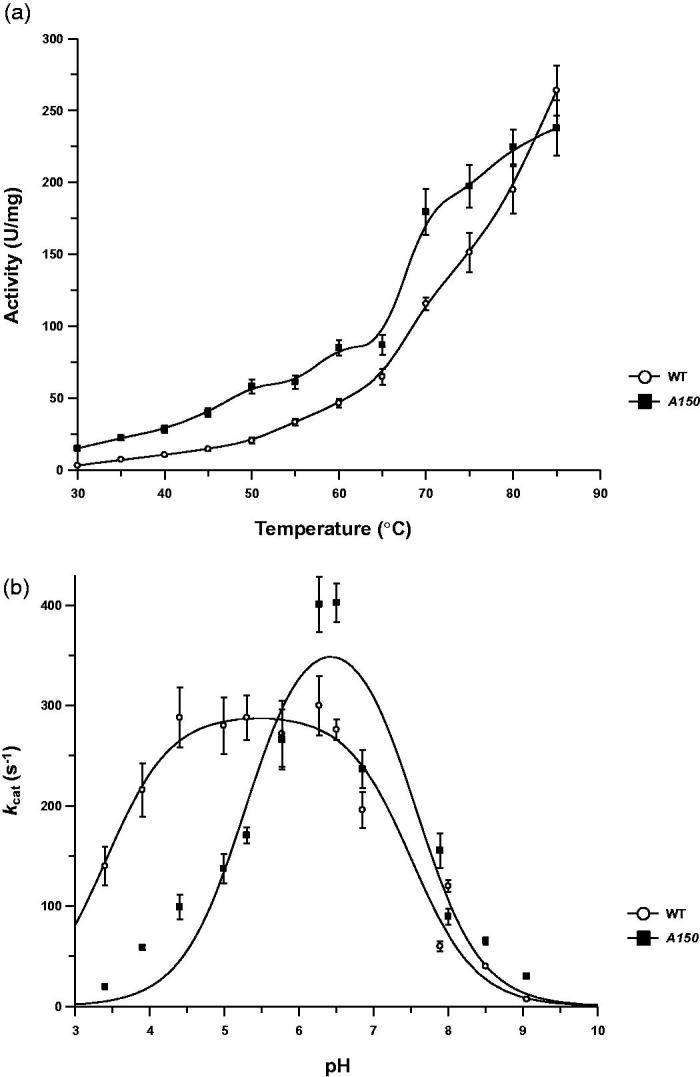
Effect of pH and temperature on wild type and mutant Ssβ-gly. Wild type Ssβ-gly (closed circles) and the A150 mutant (open squares) specific activities are shown as a function of temperature (a) and pH (b). For the wild type and mutant, the pKa1 are 3.41 ± 0.13 and 5.29 ± 0.18, while the pKa2 are 7.50 ± 0.13 and 7.54 ± 0.20, respectively.